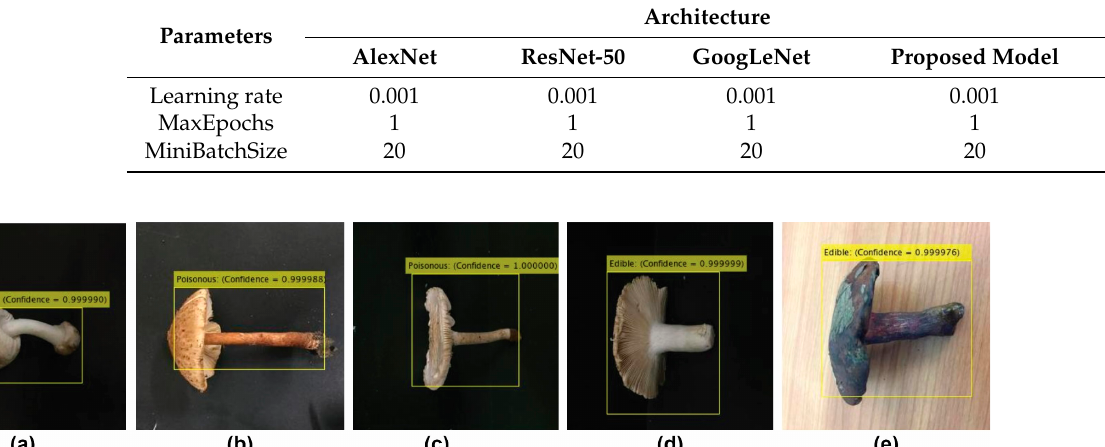
Table 6. R-CNN parameters used in training.